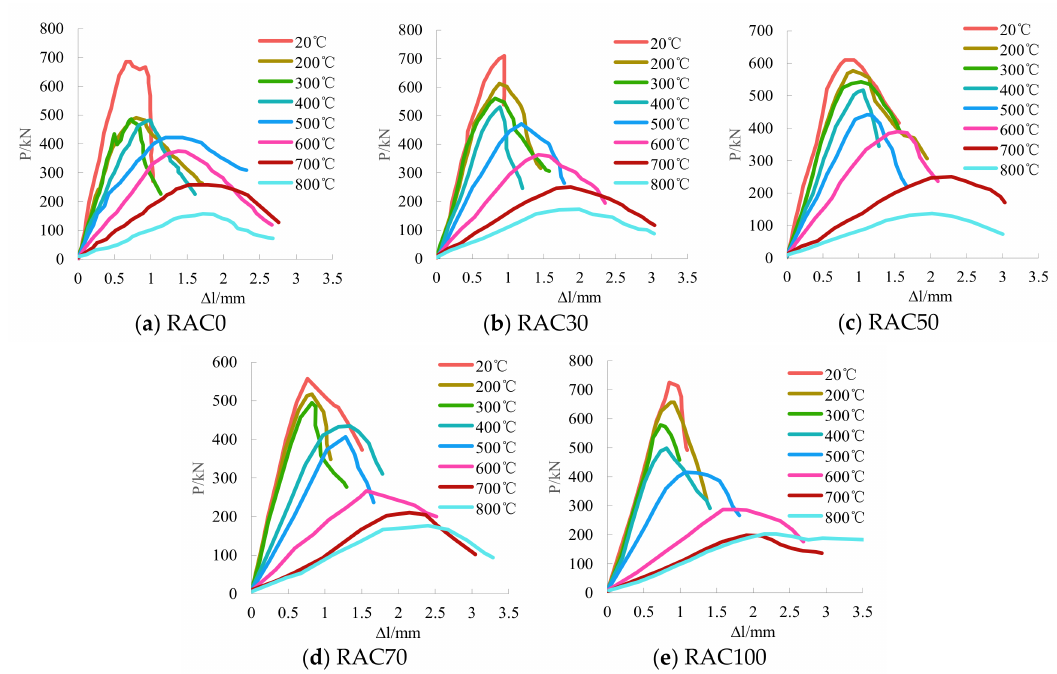
Figure 10. Load-displacement curve of rectangular prisms